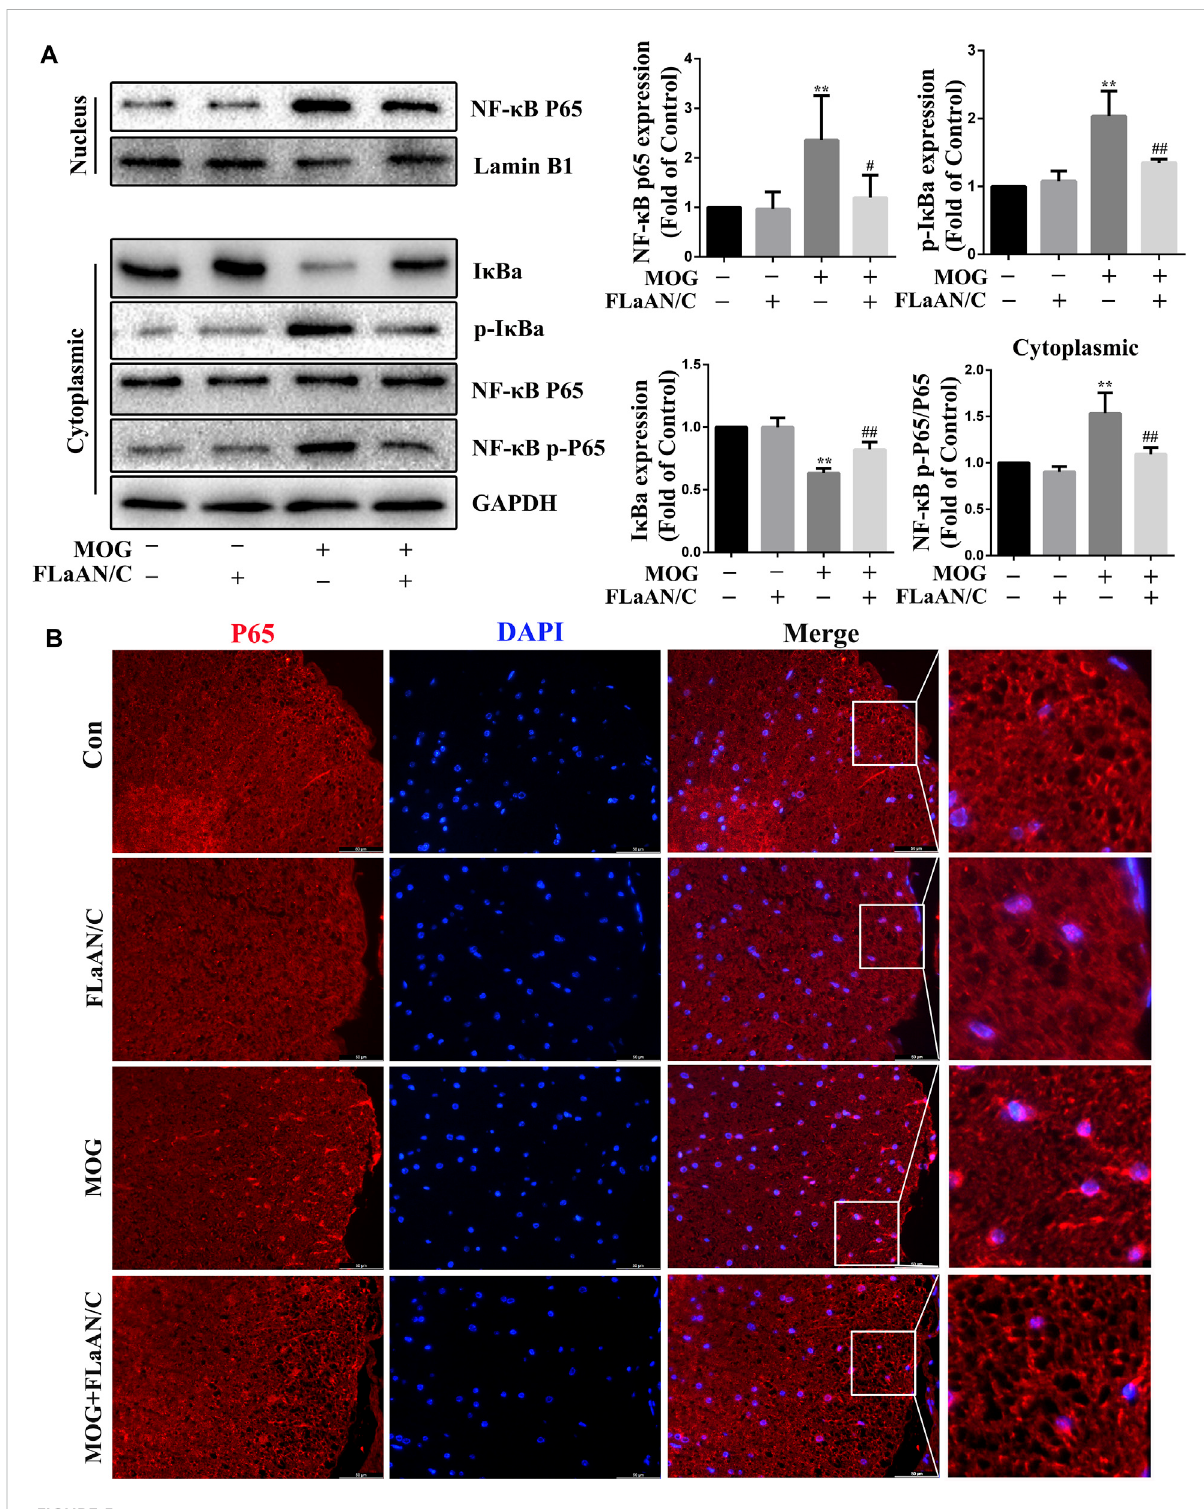
FIGURE 5 FLaAN/CinhibitedNF- κ BactivationinmicewithEAE. (A) Proteinslevelsofp-I κ B α ,I κ B α ,NF- κ B-p65,andNF- κ B-p-p65inmousespinalcord. (B) Representative immuno fl uorescence images of p65 in paraf fi n section of spinal cord tissue (scale bars:50 μ m). Data are shown as means ± SD (n = 6 per group). * p < 0.05, ** p < 0.01, *** p < 0.001; # p < 0.05, ## p < 0.01, ### p < 0.001. * vs. Control group; # vs. MOG